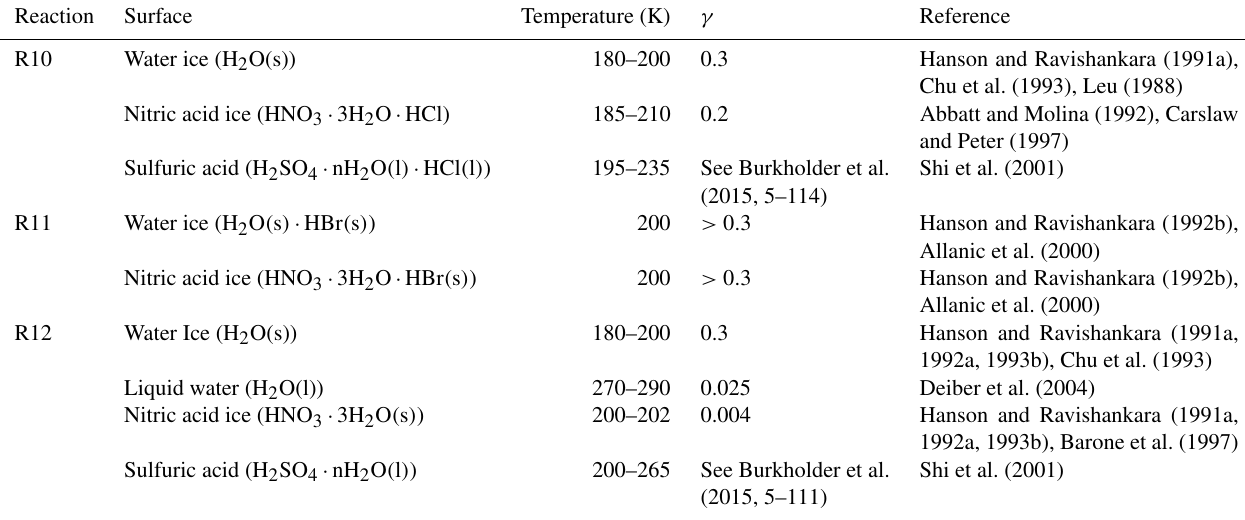
Table 4. Relevant surface reaction probabilities as recommended by Burkholder et al. (2015). Their document contains reaction probabilities for further surfaces not mentioned